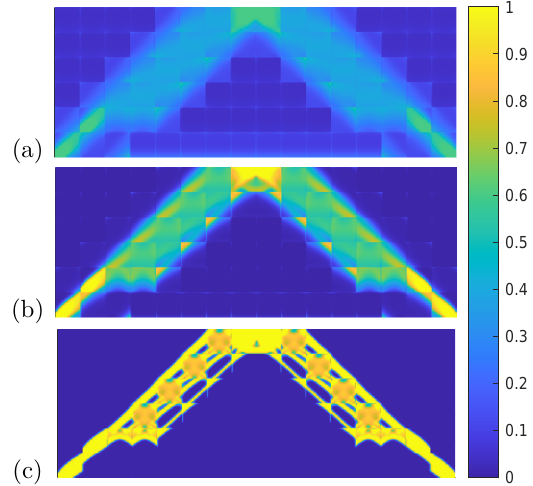
Figure 4. Three snapshots of modular topology op- timization constituting the second suite of test prob- lems: a) 4 th iteration, b) 8 th iteration, and c) 30 th iteration. Figure 5. Convergence history of 12 variants of the